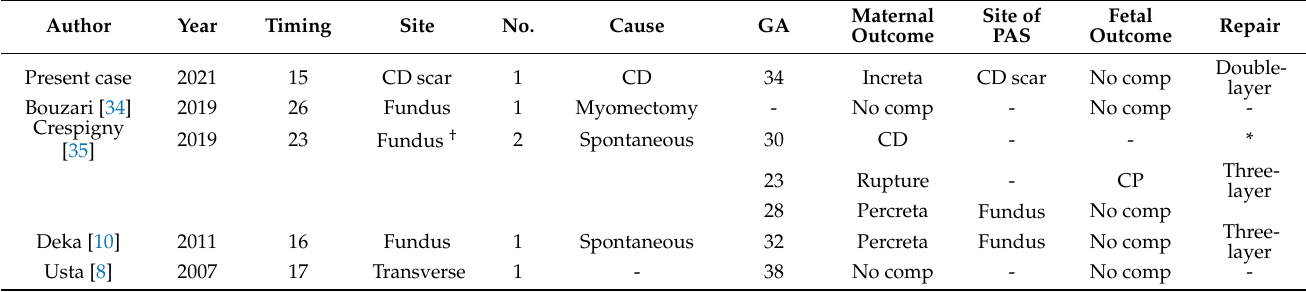
Table 1. Summary of the systematic review of literature regarding subsequent pregnancies after prior mid-trimester uterine